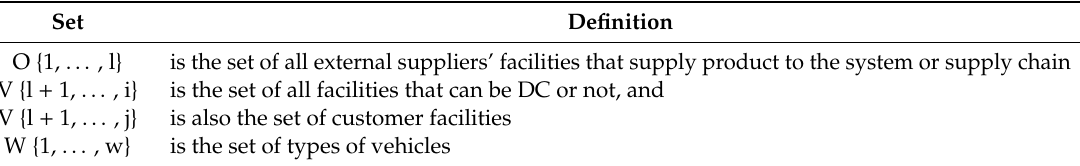
Table 1. CLITraP-HTF set of facilities.